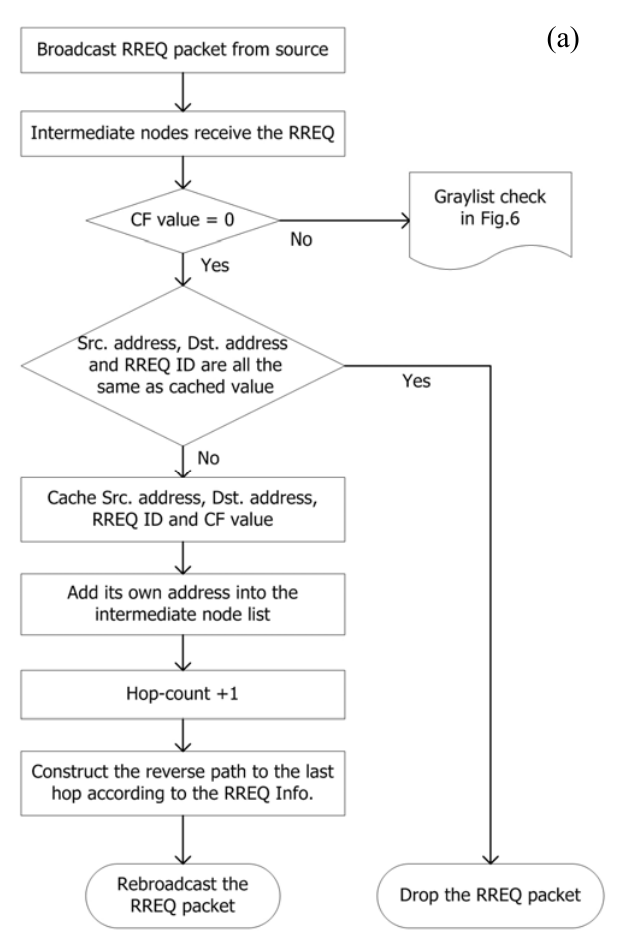
Figure 4. Route establishment in MHA protocol. (a) Processing a RREQ packet. (b) Processing a RREP